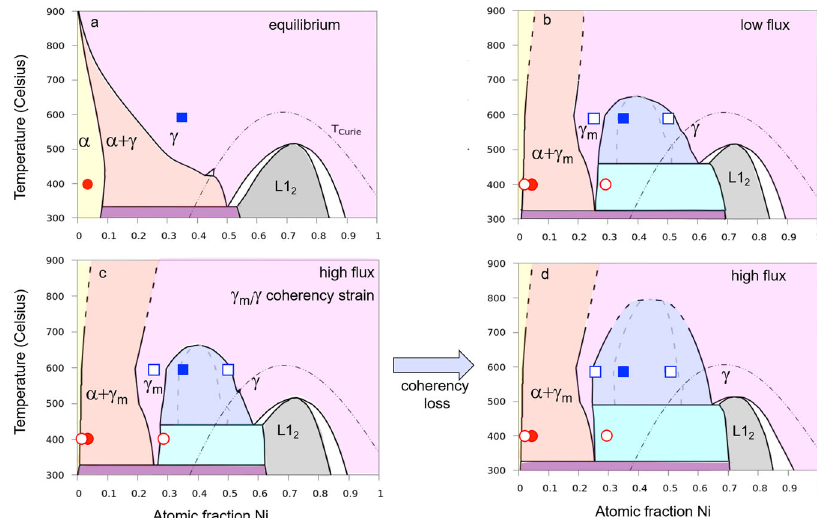
Fig. 6 Semi-coherent phase diagrams of Fe – Ni is driven by irradiation. Equilibrium ( a ) and radiation-induced metastable phase diagrams ( b , c , d ) of Fe – Ni including an SIA accommodation mechanism of the precipitate eigenstrain. In ( c ), part of the eigenstrain produced by the decomposition of phase γ is released by an elastic strain ensuring a coherent (100) interface. The γ m - γ two-phase domain widens from ( c ) to ( d ), due to the release of the coherency constraint. At low and high radiation dose rates, the temperature-dependent atomic fraction of SIAs is respectively equal to c I = 10 − 20 m 2 s − 1 / d I and c I = 10 − 14 m 2 s − 1 / d I , where c I and d I are the atomic fraction and diffusion coef fi cient of SIAs. The product d I c I is related to the radiation fl ux and the overall annihilation strength of the microstructure acting as sinks of point defects (cf the “ Methods ” ). The dotted-dashed line and gray dashed line are respectively for the Curie temperature and the spinodal limit. In temperature domains at which there are no experimental lattice parameters, boundary limits are plotted as dashed lines. Full symbols are the nominal compositions and open symbols are the compositions of the precipitated and parent phases measured after irradiation. Circles are for the radiation-induced bcc-fcc phase transformation and squares are for the spinodal decomposition of austenite irradiated with neutrons 50 at 600